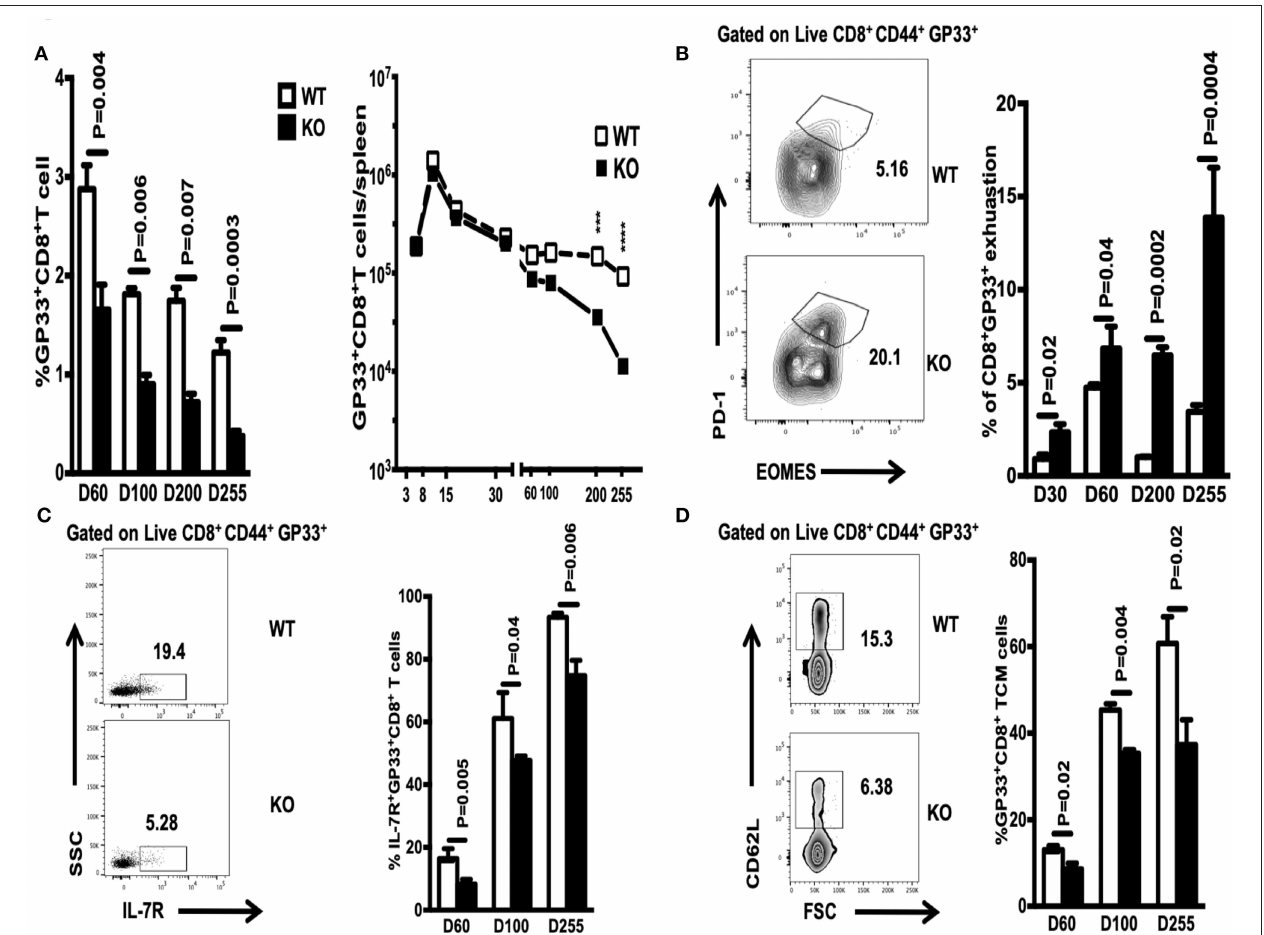
FIGURE 5 | WASp deficiency limits the size of the CD8 + memory T cell compartment and promotes CD8 + T cell exhaustion. On the indicated days PI, WT and WASp − / − mice were scarified and the percentage and absolute number of GP33-specific CD8 + T cells in the spleen were enumerated by Tetramer staining. (A) Percentage and absolute number of GP33-specific CD8 + T cells on the indicated days. (B) Left panel, representative data for exhausted T cells on D255; right panel, percentage of exhausted CD8 + T cells within the GP33-specific cell population on the indicated days. (C) Left panel, representative data showing IL-7R + GP33 + T cells on D60; right panel, percentage of IL-7R + GP33-specific CD8 + T cells on the indicated days. (D) Left panel, representative data showing TCMs on D60; right panel, percentage of TCMs on the indicated days. Data are expressed as the mean ± SEMs ( n = 3 to 8 mice) (WT littermate mice: D30, n = 4; D60, n = 7; D100, n = 7; D200, n = 3; D255, n = 5; WASp − / − mice: D30, n = 4; D60, n = 8; D100, n = 7; D200, n = 3; D255, n = 5). Data were analyzed using an unpaired t